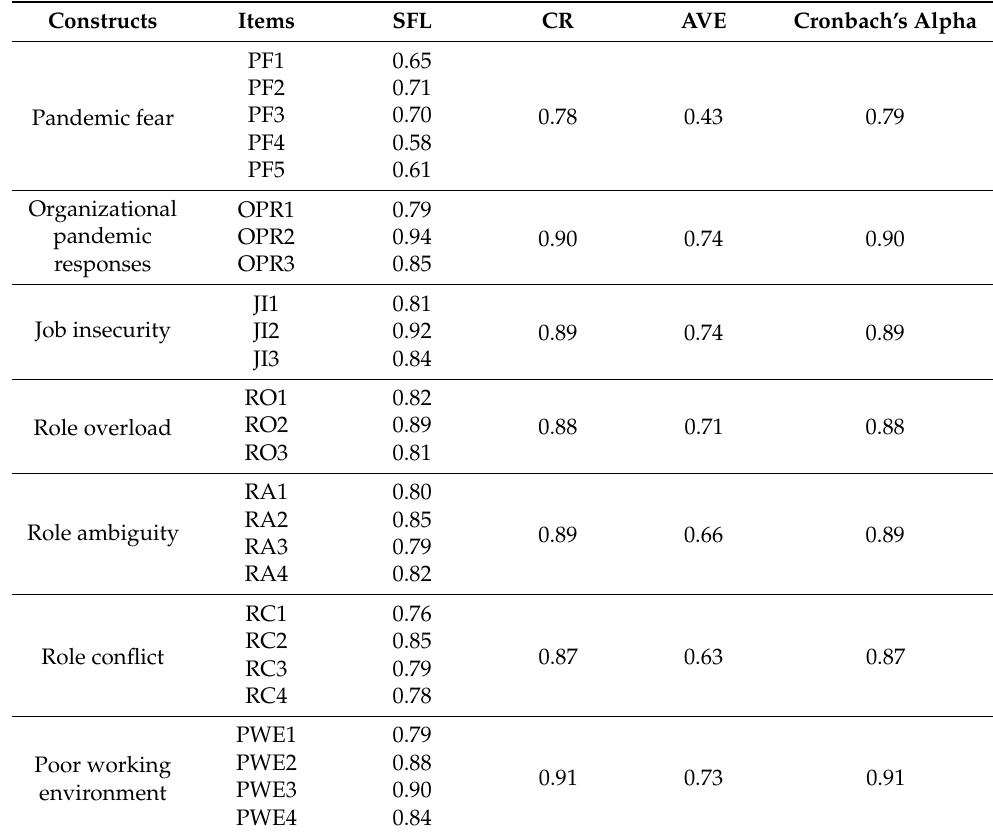
Table 4. Results of reliability and convergent validity for